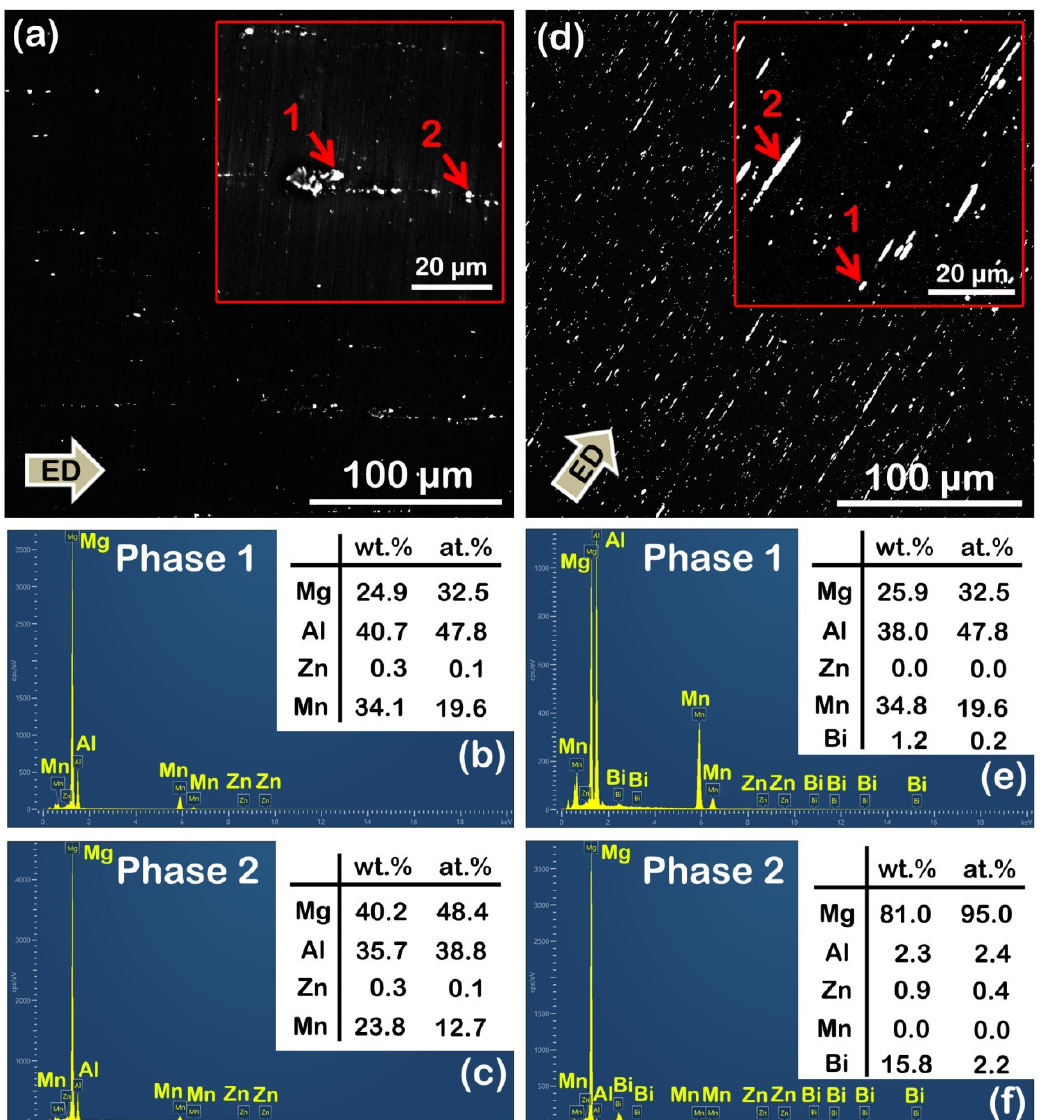
Figure 5. ( a , d ) Low-magnification SEM images of as-extruded AZ31 and AZB313 alloys, respectively; ( b , c ) SEM point scanning results of phases 1 and 2 marked by red arrows in ( a ); ( e , f ) SEM point scanning results of phases 1 and 2 labeled by red arrows in ( b ).